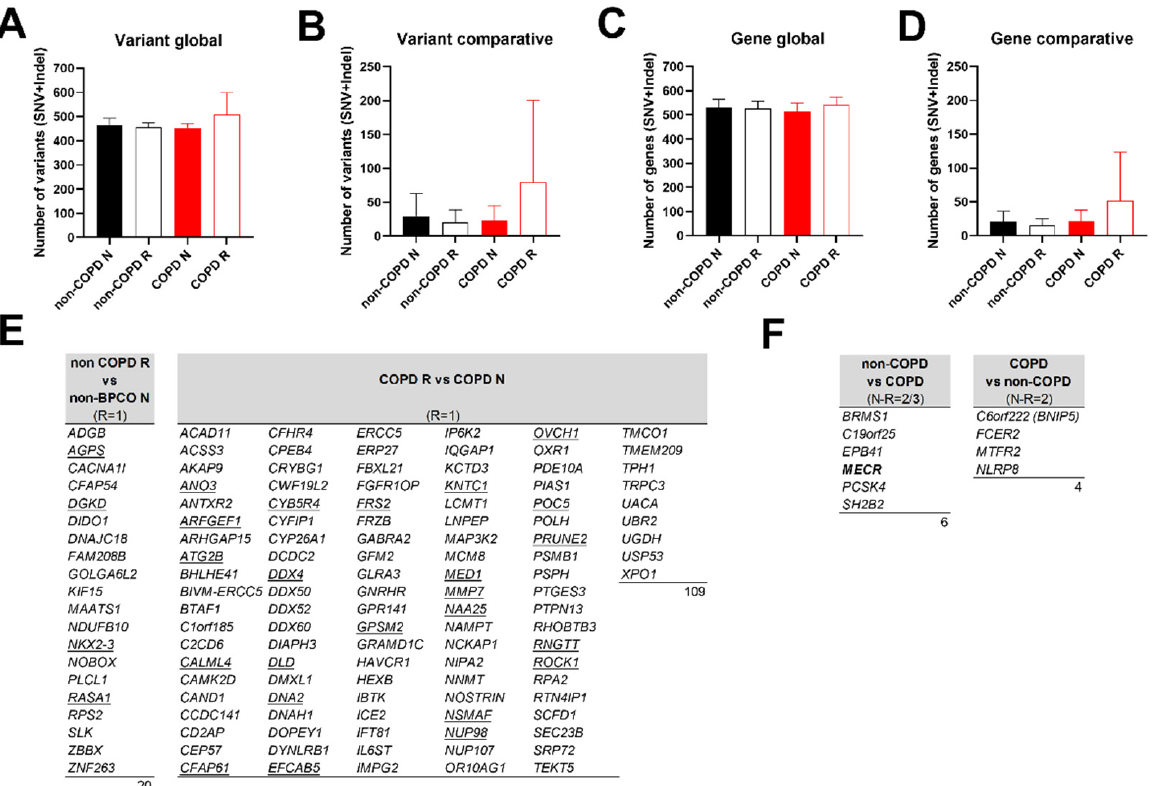
Figure 2. Identification of genetic variations in COPD microdissected remodelled epithelia. Histograms (mean +/ − SEM) showing the number of identified positions or genes with variants according to respiratory status and tissue morphology (N: non-remodelled; R: remodelled). ( A ) Identical positions between N and R were retained ( B ) or removed. ( C ) Identical genes between N and R were retained ( D ) or removed. ( E ) Potential frequent genes variants of remodelled non-COPD and COPD tissue. Genes presenting an SNV or an Indel in the remodelled tissue and absent in the non-remodelled tissue for the same position. Non-COPD R vs. non-COPD N: variants in non-COPD R not found in non-COPD N. COPD R vs. COPD N: variants in COPD R not found in COPD N. These variants were only found in one R sample (R = 1). Underlined genes are for the variants assumed to have high (disruptive) impact in the protein. ( F ) Lists of potential frequent gene variants of COPD susceptibility. Genes with identical SNV/Indel between non-remodelled and remodelled tissue for 2 or 3 samples (N-R = 2/3 (bold)). Non-COPD vs. COPD: variants in non-COPD not found in COPD. COPD vs. non-COPD: variants in COPD not found in non-COPD. See Supplementary Materials: Table S1 for impact description.